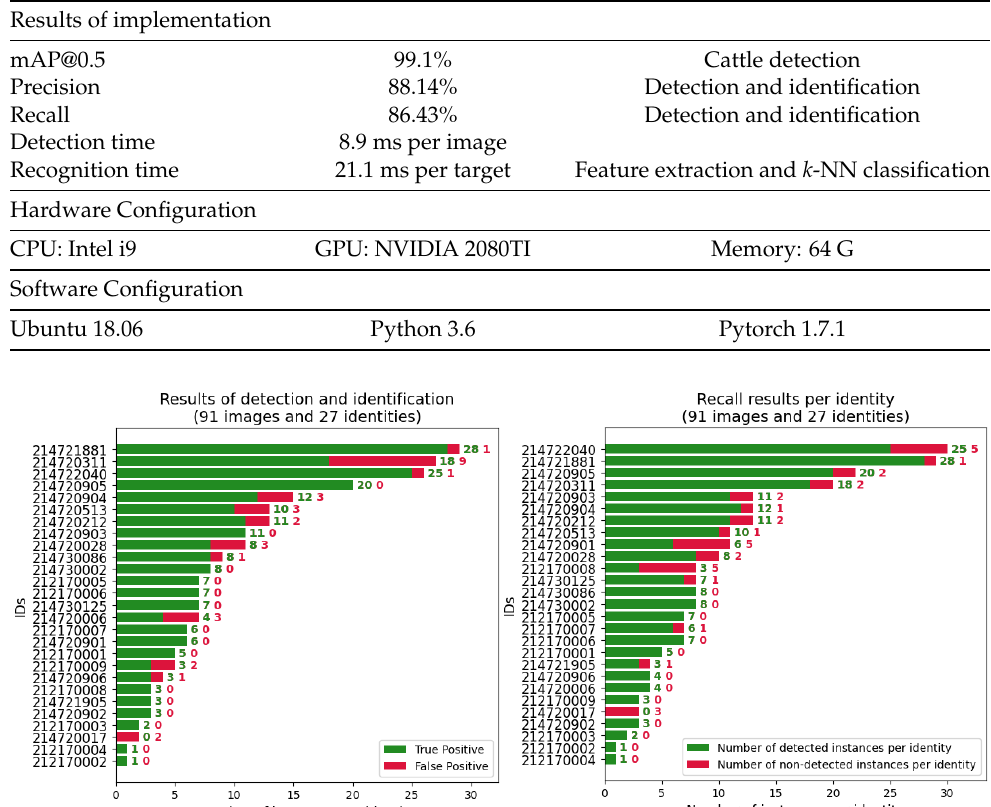
Table 5. Implementation details for the engineering application.